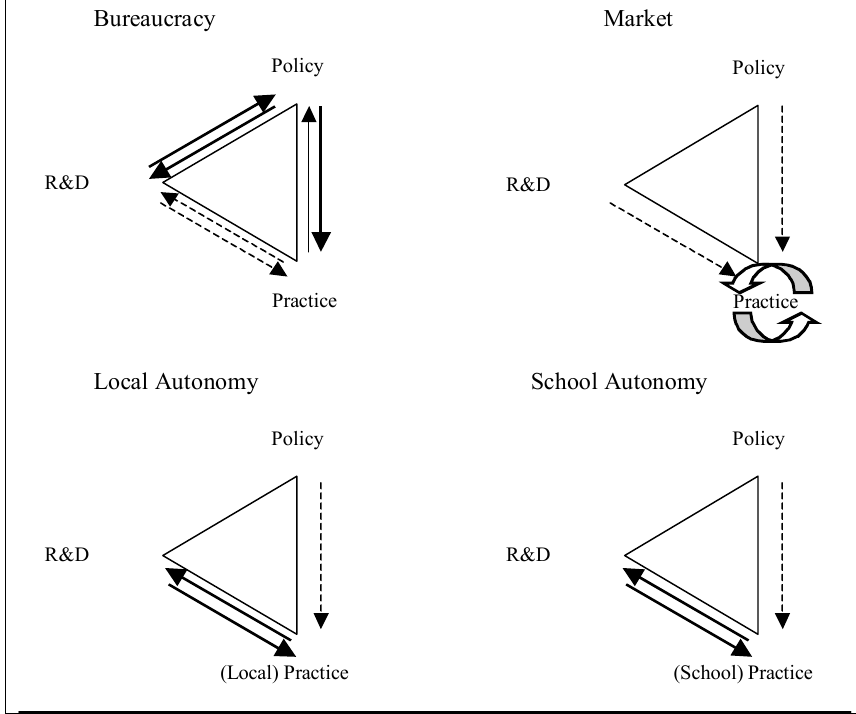
Figure 3. Stylised relationship between evidence-based policy and forms of